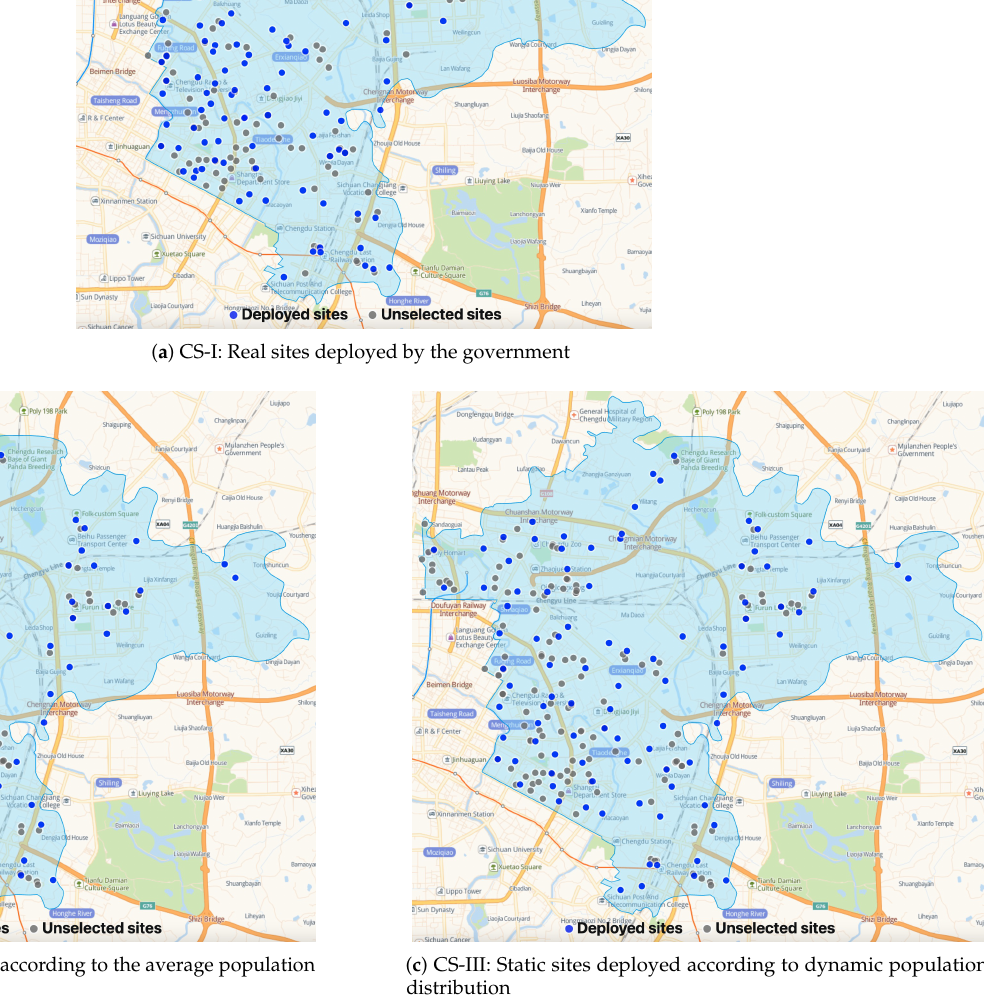
Figure 6. The static site deployment plan of other